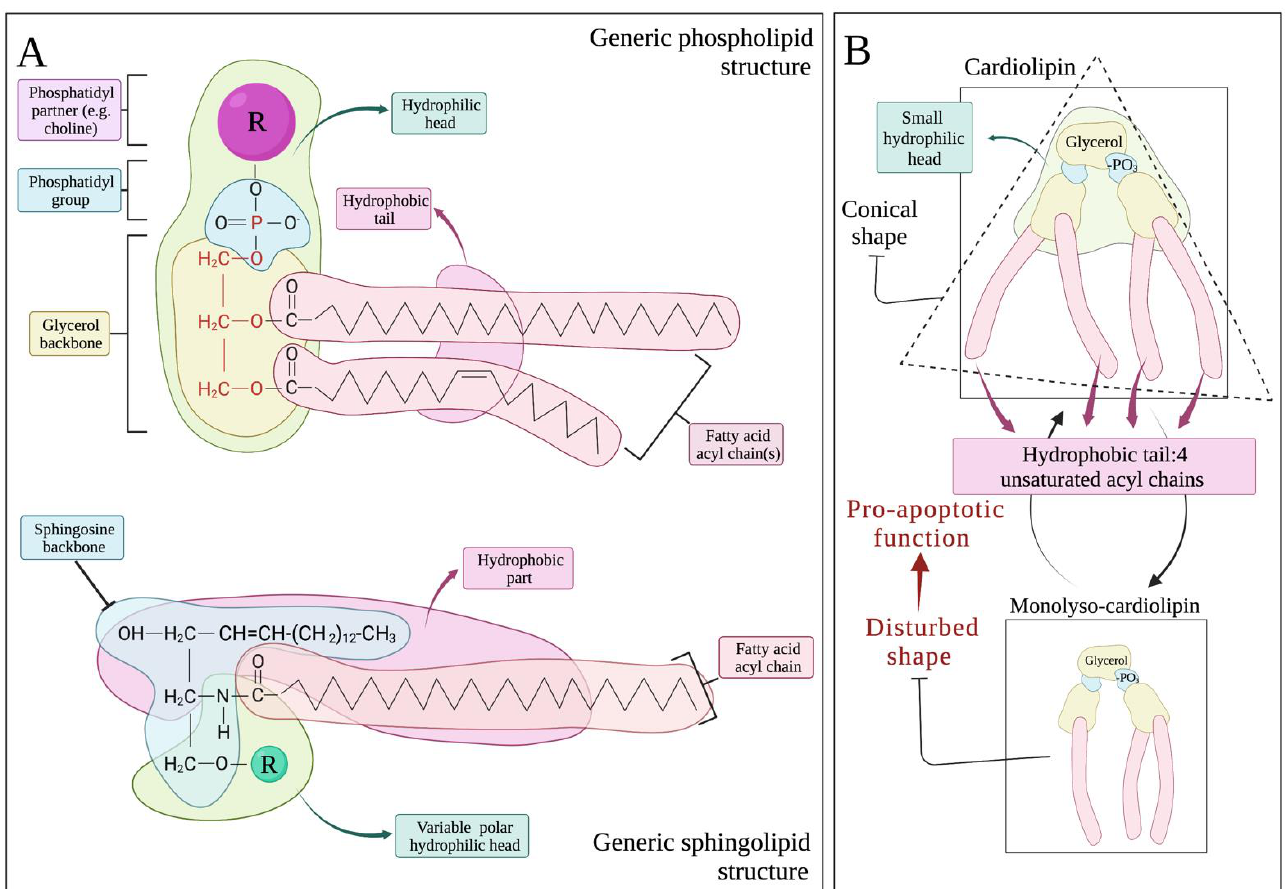
Figure 3. ( A ) Schematic presentation of phospholipids and sphingolipids generic structure . ( B ) Schematic presentation of the conical tertiary structure and rough composition of cardiolipin (CL) . Monolyso-CL is also shown. Created with BioRender.com, accessed on 21 March